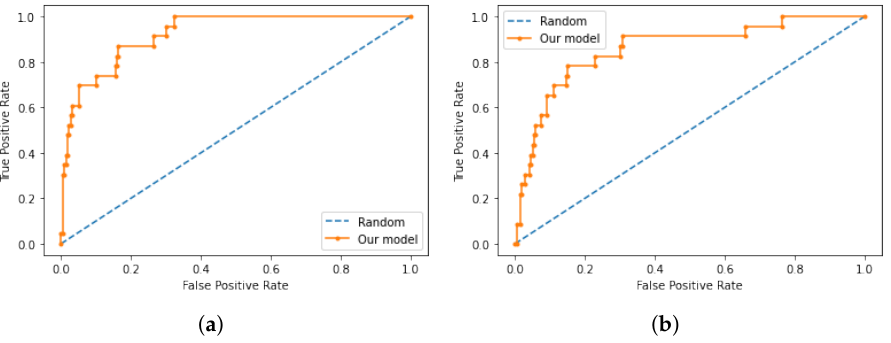
Figure 4. ROC curves for the test dataset. ( a ) 24 h forecasting, ( b ) 48 h